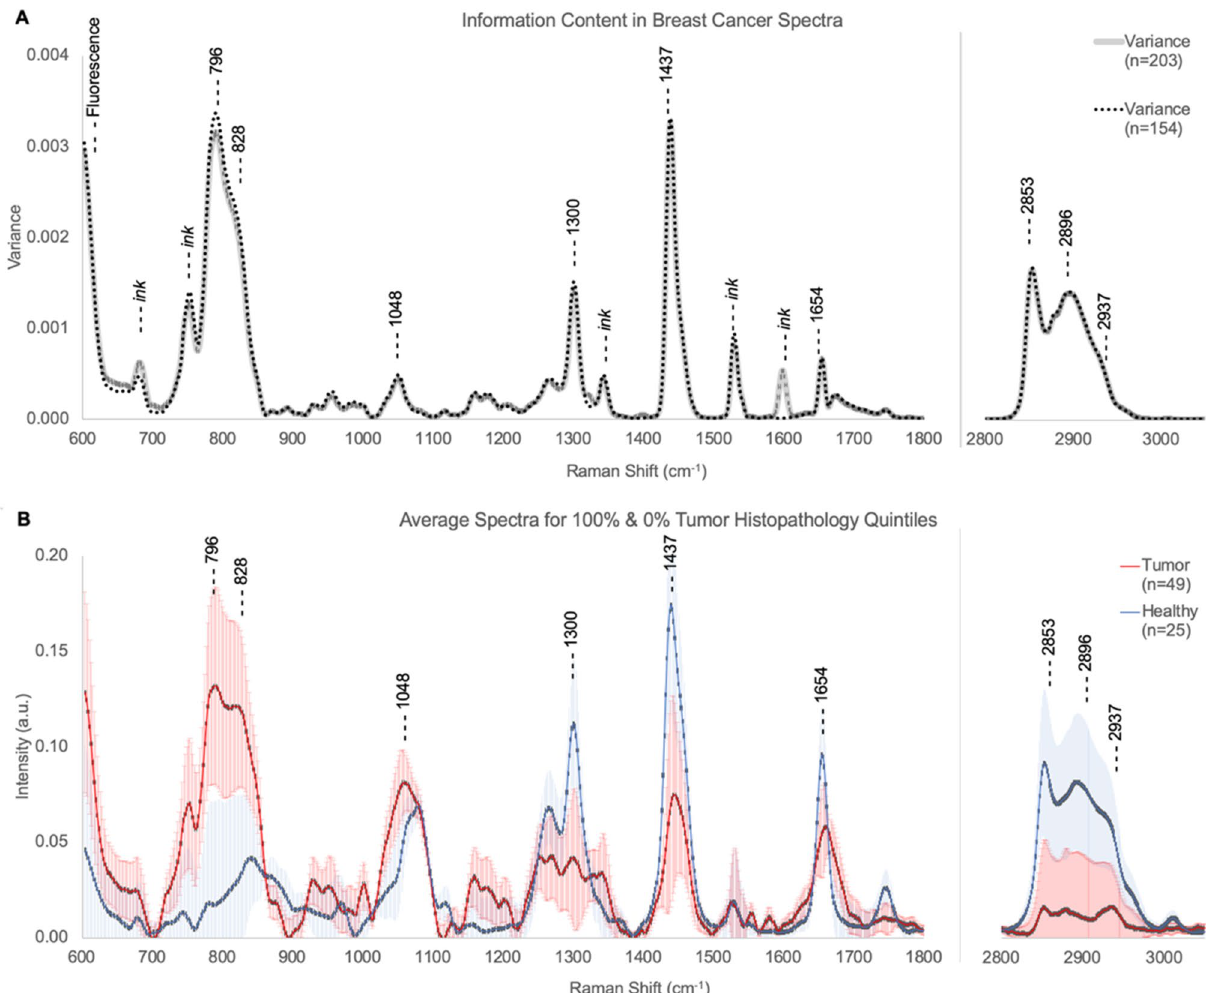
Figure 2. Information content of laser Raman spectra of healthy and cancerous tissue. Spectral variance for the full data set (203, 8 patients) and for the histopathology subset (n = 154, 5 patients) appears in ( A ). Spectral regions known to be at risk for contamination by surgical ink are noted. The 9 bands selected from the most information-rich (high variance) regions without evidence of ink contamination are shown. See Fig. S2 in Supplementary materials for Raman spectra of surgical inks. See Table 1 for band assignments. ( B ) Shows the average spectra with 1-sigma error bars for the histopathology 100% (Tumor, n = 49) and 0% (Healthy, n = 25) quintiles.